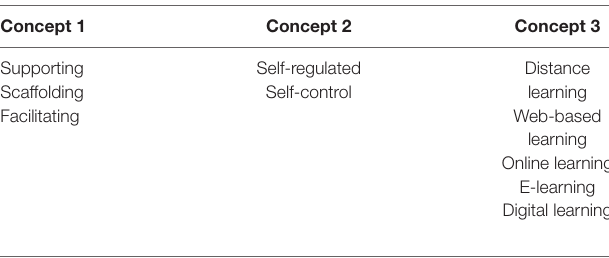
TABLE 1 | Concepts explored and included in the